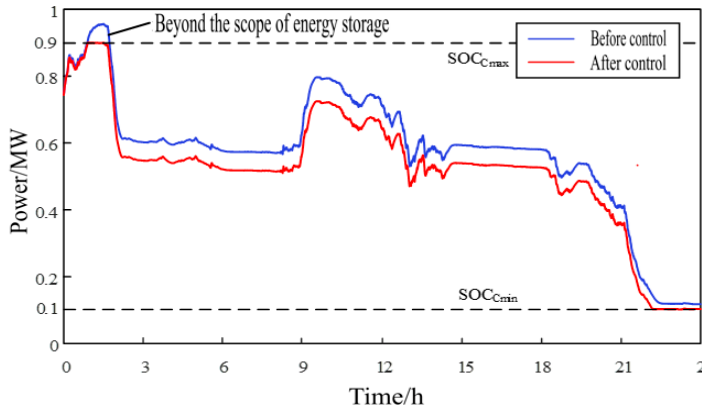
Figure 9. SOC comparison of supercapacitor before and after control.